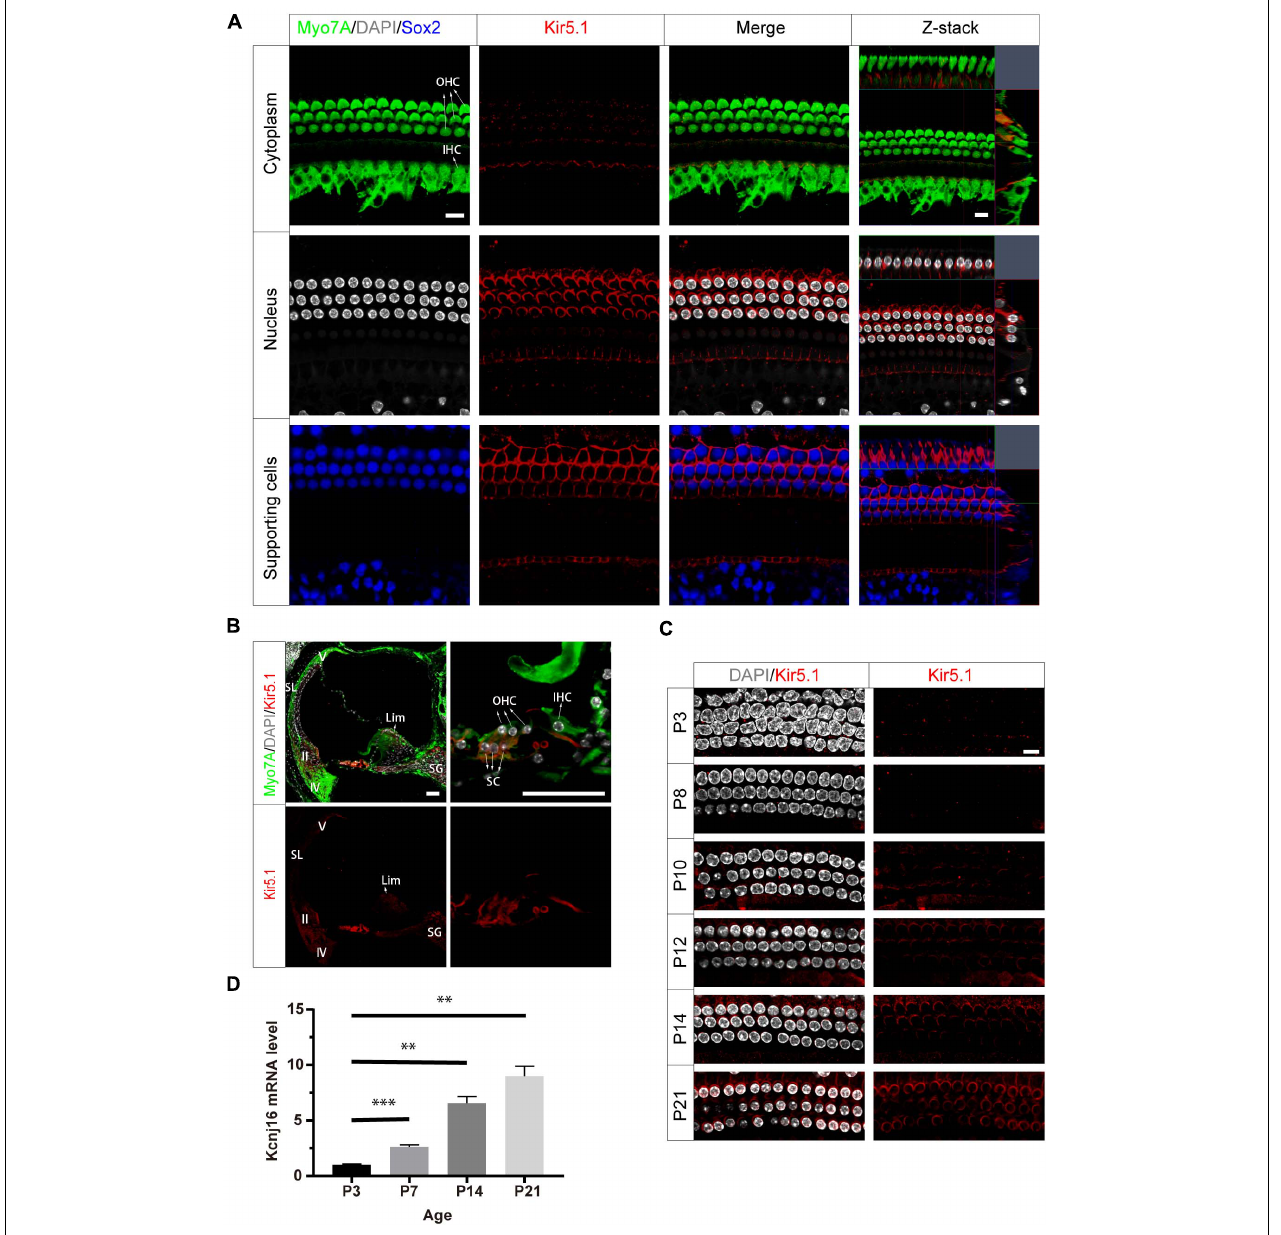
FIGURE 2 | Expression of Kir5.1 in the WT mouse cochlea. (A) Immunofluorescence staining with antibodies against Kir5.1 (red), Myo7A (green), and Sox2 (blue) and DAPI staining (white) in the basal turn of the mouse cochlea at P90. There was no difference in the immunolabeling of Kir5.1 from the apical to basal turns. Scale bar = 10 µ m. (B) Immunohistochemical staining with antibodies against Kir5.1 (red) and Myo7A (green) and DAPI staining (white). Scale bar = 50 µ m. (C) Immunofluorescence staining with antibodies against Kir5.1 (red) and DAPI staining (white) in the cochlea at P3, P8, P10, P12, P14, and P21. Scale bar = 10 µ m. (D) Q-PCR results showing the changes in Kcnj16 mRNA in the mouse cochlea from P3 to P21. GAPDH was used as the internal control. Primers are shown in the Supplementary Table 2 . Data are presented as the mean ± SD. ∗∗ p < 0.01, ∗∗∗ p < 0.001, n = 4. OHC, outer hair cell; IHC, inner hair cell; SC, supporting cell; SL, spiral ligament; II, IV, V, type II, IV, and V fibrocytes in the spiral ligament. Lim, spiral limbus; SG, spiral ganglions.